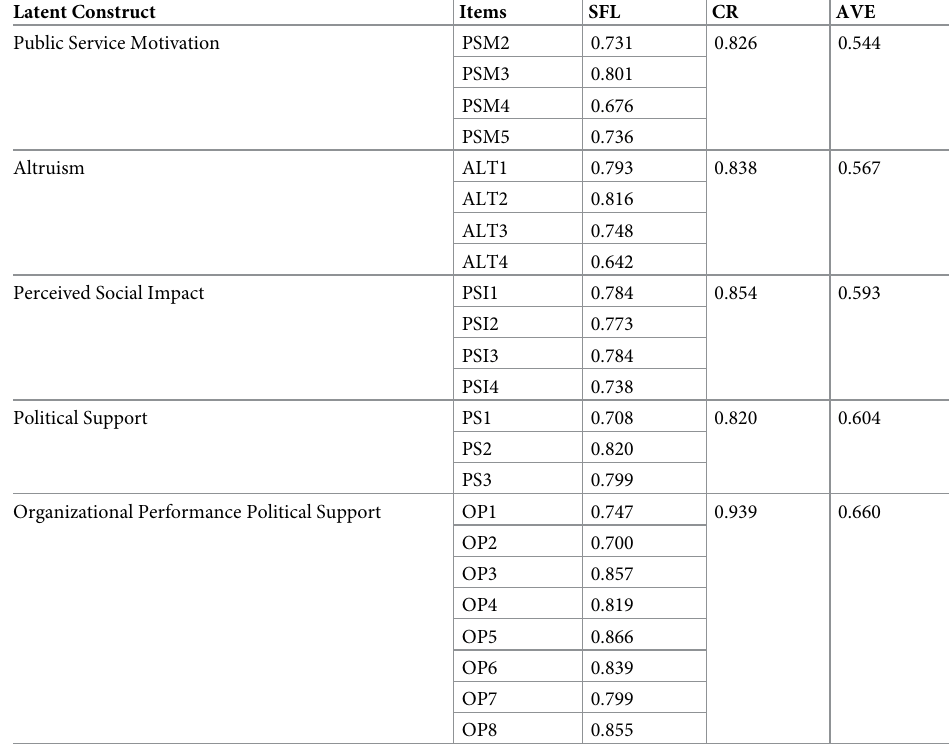
Table 3. Composite reliability and convergent